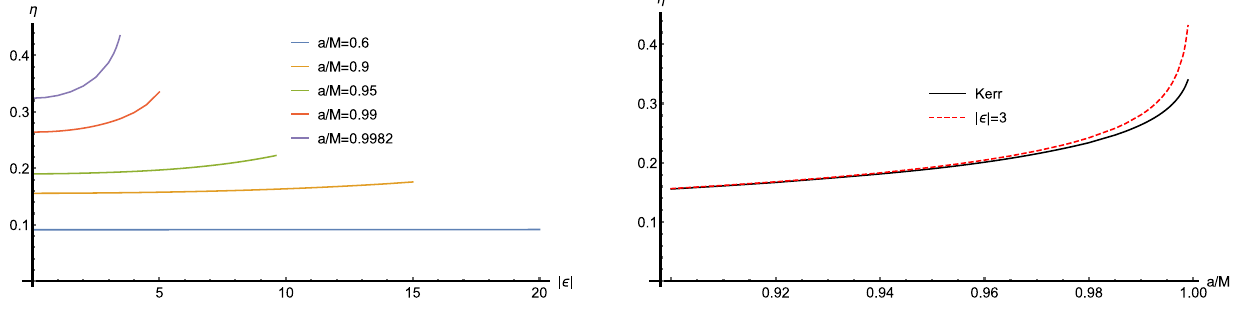
Fig. 4 (Left): The radiative efficiency η as a function of the deviation parameter | (cid:2) | . Different curves represent different values of the black hole spin, as indicated by the legend. Each curve terminates at a certain | (cid:2) | when the ISCO coincides with the naked singularity. (Right): The